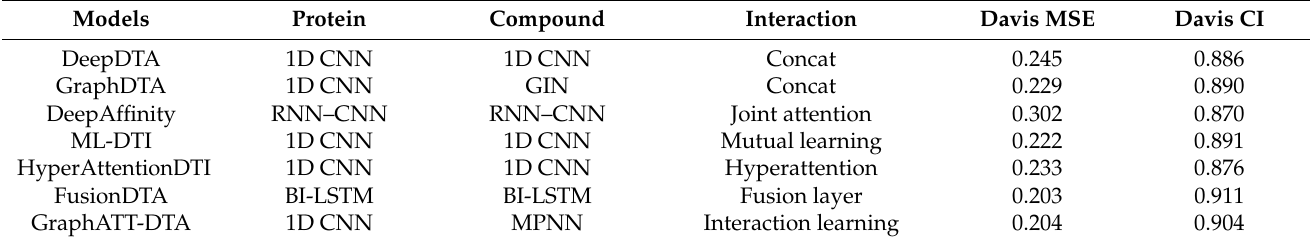
Table 6. GraphATT-DTA prediction performance on the Davis testing dataset vs. baseline models.